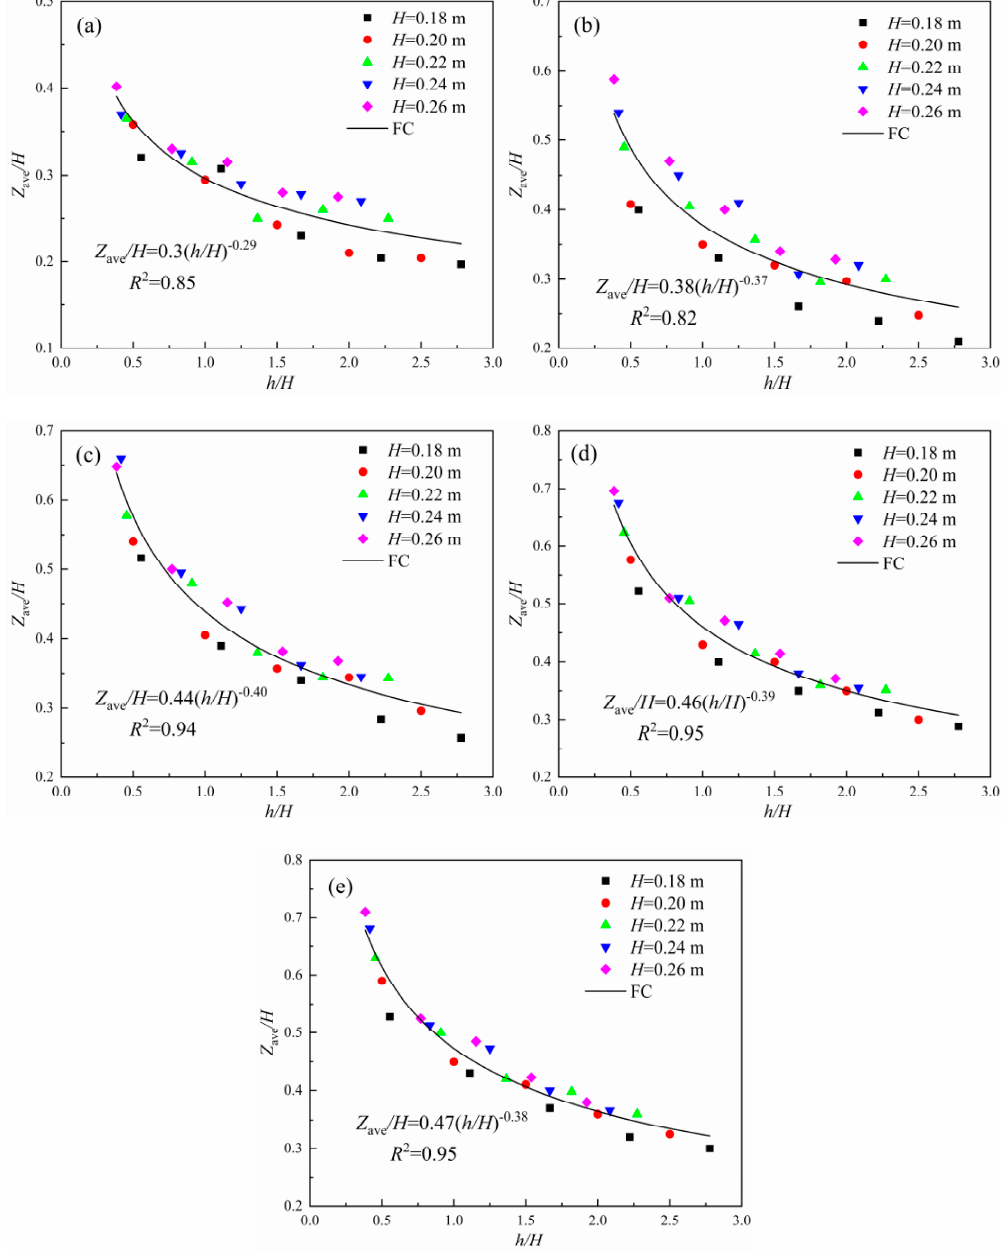
Figure 9. Z ave / H relationship with h/H . ( a ) T = 1.5 s; ( b ) T = 1.8 s; ( c ) T = 2.1 s; ( d ) T = 2.4 s; ( e ) T = 2.7 s.